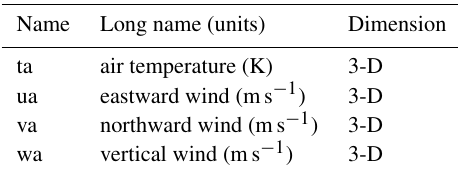
Table 4. Equatorial wave spectra. The 6-hourly instantaneous 3-D (XYPT) equatorial field (15 ◦ N to 15 ◦ S) output for selected sub- periods of each experiment (see Sect. 4.2). Here P is not the stan- dard set of pressure levels used in Tables 1–3. Rather, as described in Sect. 4.1, it indicates a set of pressure levels with equivalent verti- cal resolution to the model levels, covering the altitude range 100 to 0.4hPa. Alternatively the data can be provided on actual model lev- els, although in this case the data required for conversion between model and pressure levels must also be